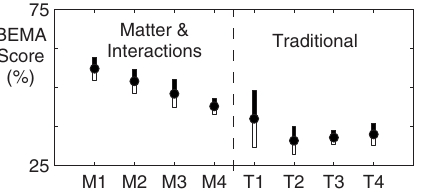
FIG. 7. Average BEMA score by section at NCSU—the average end-of-semester BEMA scores for four traditional (cid:1) T# (cid:2) and four M&I (cid:1) M# (cid:2) sections at NCSU are shown. The error bars indicate 95% confidence intervals on the estimates of the average for each section. The numbers of students tested: N =7 for T1, N =10 for T2, N =16 for T3, N =15 for T4, N =16 for M1, N =22 for M2, N =10 for M3, and N =31 for M4. Note that section M4 was taught in the SCALE-UP